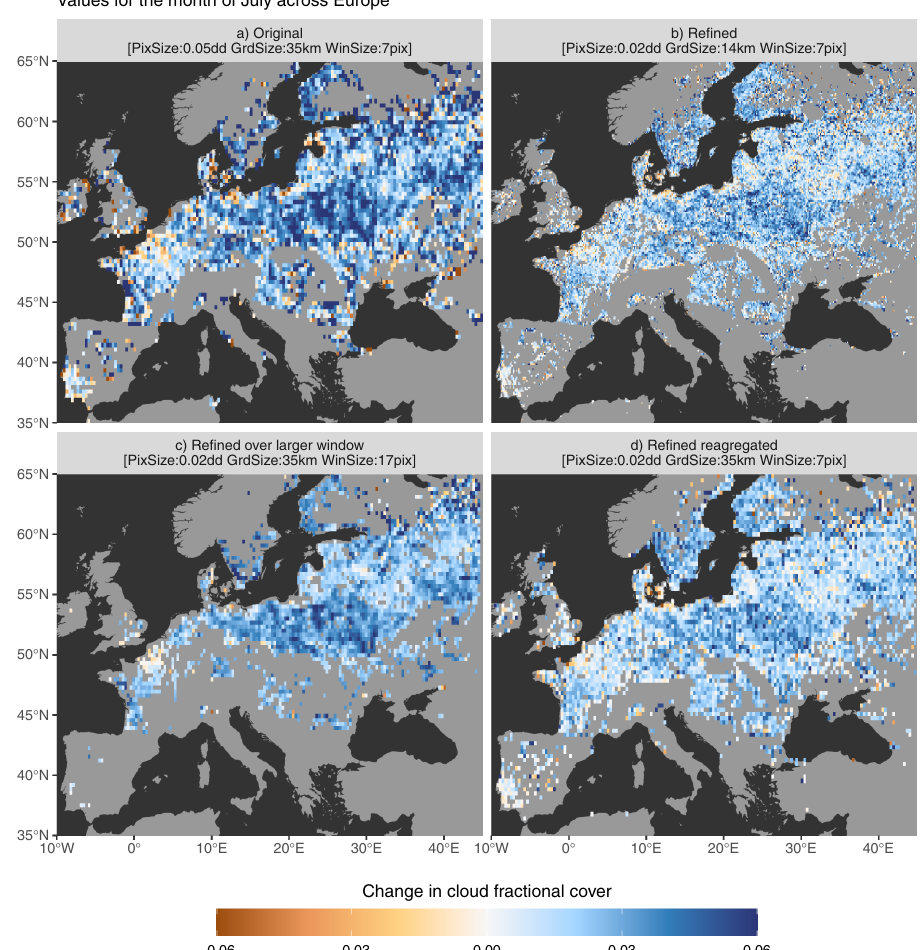
Fig. 6 Exploring the effect of a change in scale on the methodology to extract the change in cloud fractional cover (CFrC) following potential afforestation over Europe. The original procedure applied at global scale with 0.05° data is presented in ( a ), while the same approach applied to a fi ner dataset of 0.02° is represented in ( b ). Panel ( c ) provides an alternative approach in which the fi ne spatial-scale data is used using a moving window of equivalent size to that used in the original method, thus involving more pixels. For comparison purposes, panel ( d ) provides the same information as panel ( b ), but aggregated to the same grid as those in ( a ) and ( c